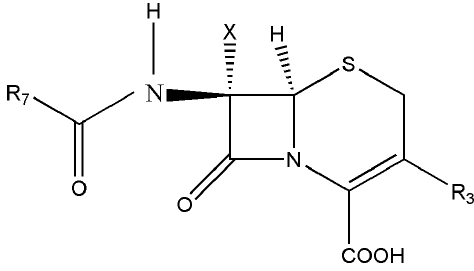
Fig. 1. The chemical structure of